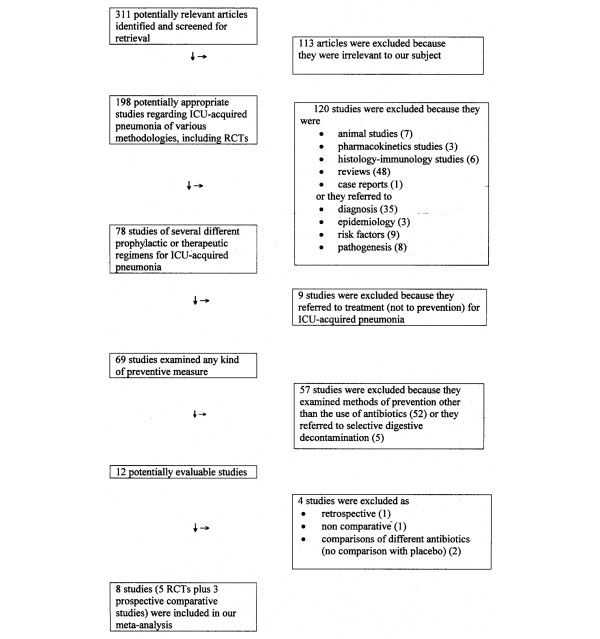
Flow diagram of reviewed articles.